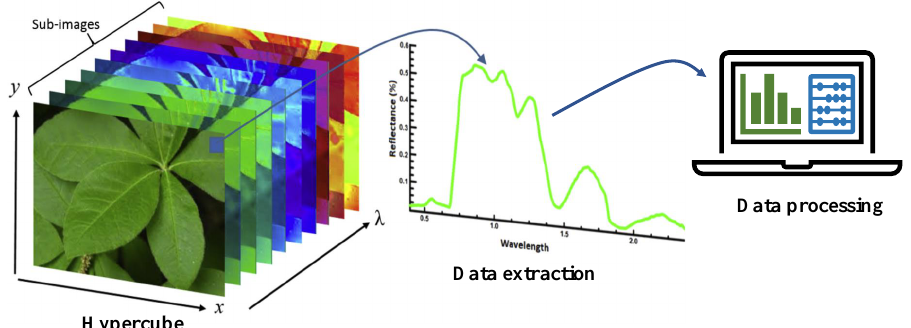
Figure 8. General workflow of hyperspectral imaging-based plant disease detection. Adapted from [96], Copyright (2017), with permission from